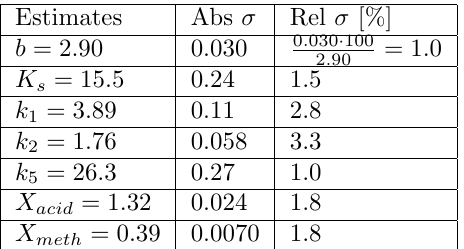
Table 6: Values of estimated variables and parameters, and absolute and relative standard deviations ( σ ). Units are listed in Appendix A.2. The standard deviations are found from bootstrap- ping simulations as described in the present section.